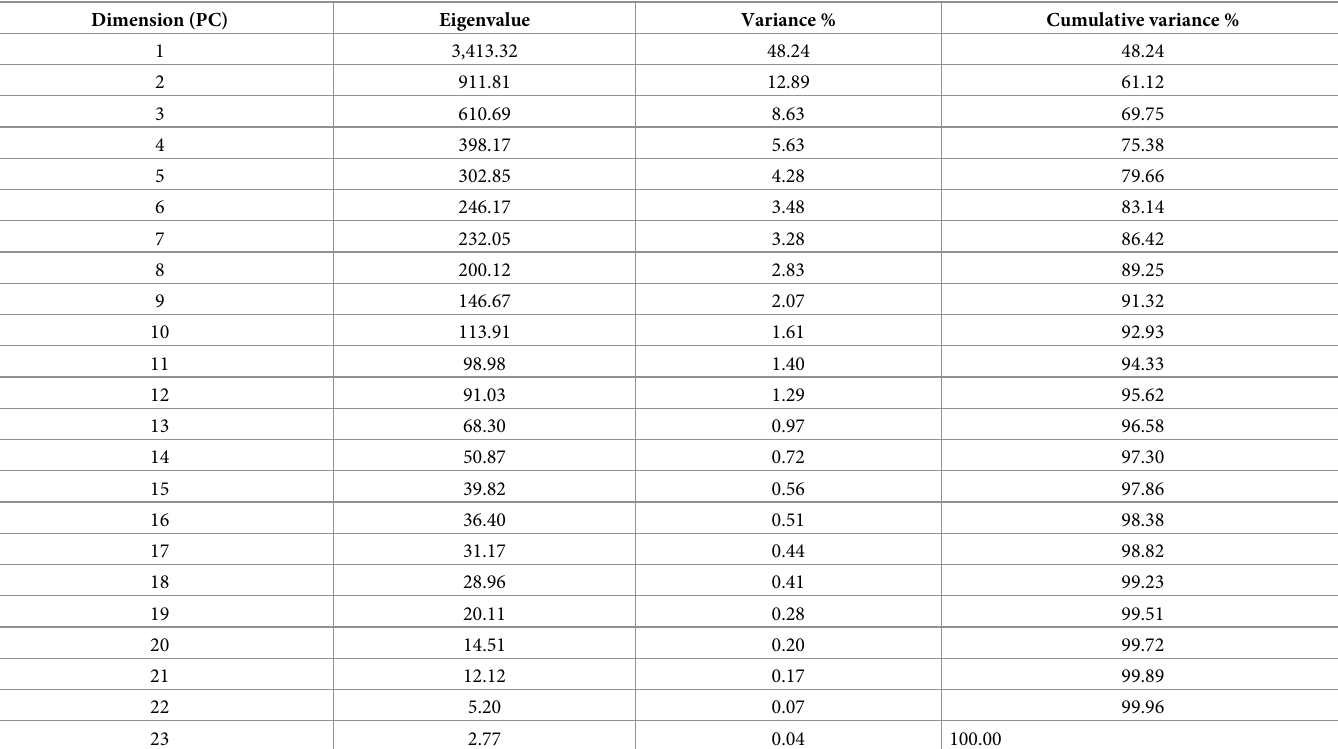
Table 1. Eigenvalues, % variance, and % cumulative variance associated with the principle components (PC). Dimension